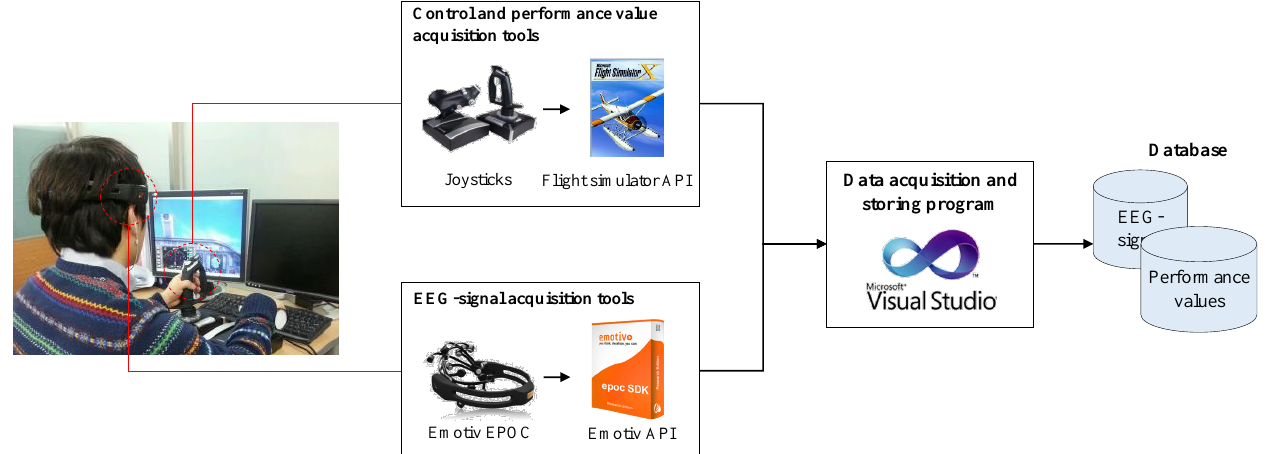
Figure 2. Details of data acquisition step in signal processing